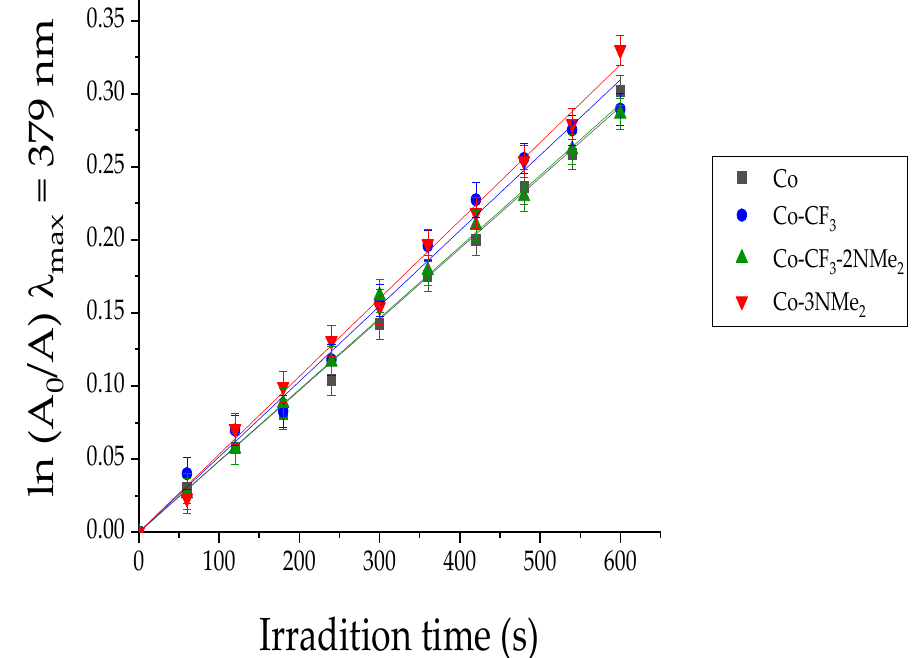
Figure 2. First-order plots for the decomposition of DMA photosensitized by Co-3NMe 2 (red line), Co-CF 3 (blue line), Co-CF 3 -2NMe 2 (green line), and the reference Co (black line) in DMF; λ irr = 606 nm. Values represent mean ± standard deviation of three consecutive experiments.